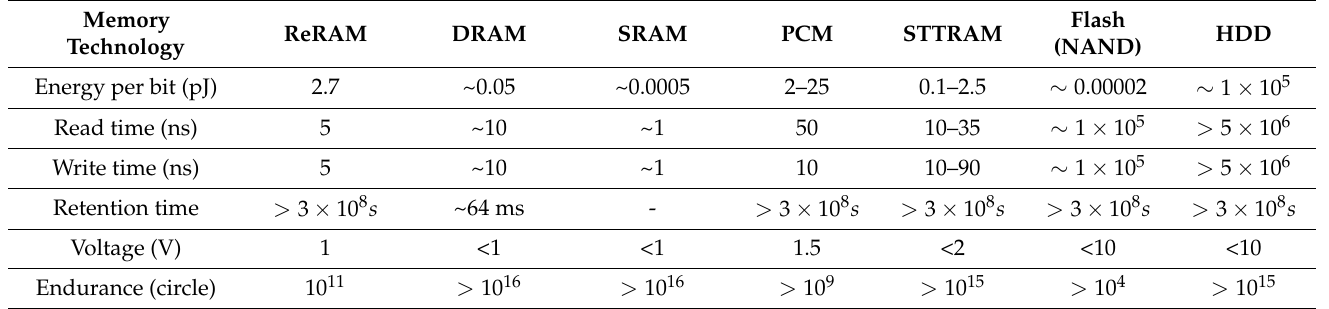
Table 1. Comparisons between different types of memory device